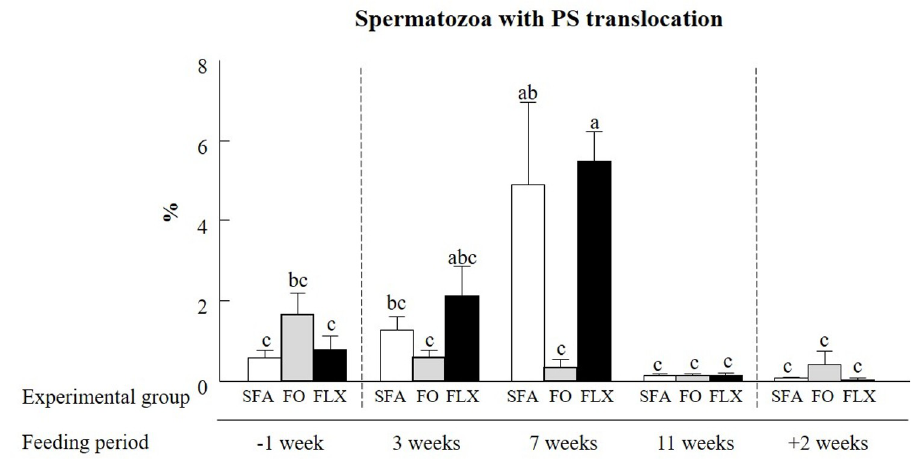
Fig 6. The effect of omega-3 sources flaxseed and fish oil on phosphatidylserine (PS) translocation. The proportion of spermatozoa with PS translocation within each experimental group: saturated fatty acid (SFA; control), fish oil (FO), and flaxseed oil (FLX), as determined by flow cytometer detection of the fluorescent probes annexin V and PI during the experimental period: before (-1 week), during (3, 7, and 11 weeks), and after (+2 weeks) the feeding trial is presented. Data are presented as the mean ± SEM calculated for 5 replicates with 5000 spermatozoa per replicate. Different letters above the columns indicate significant differences between experimental groups at each time point ( P < 0.05).